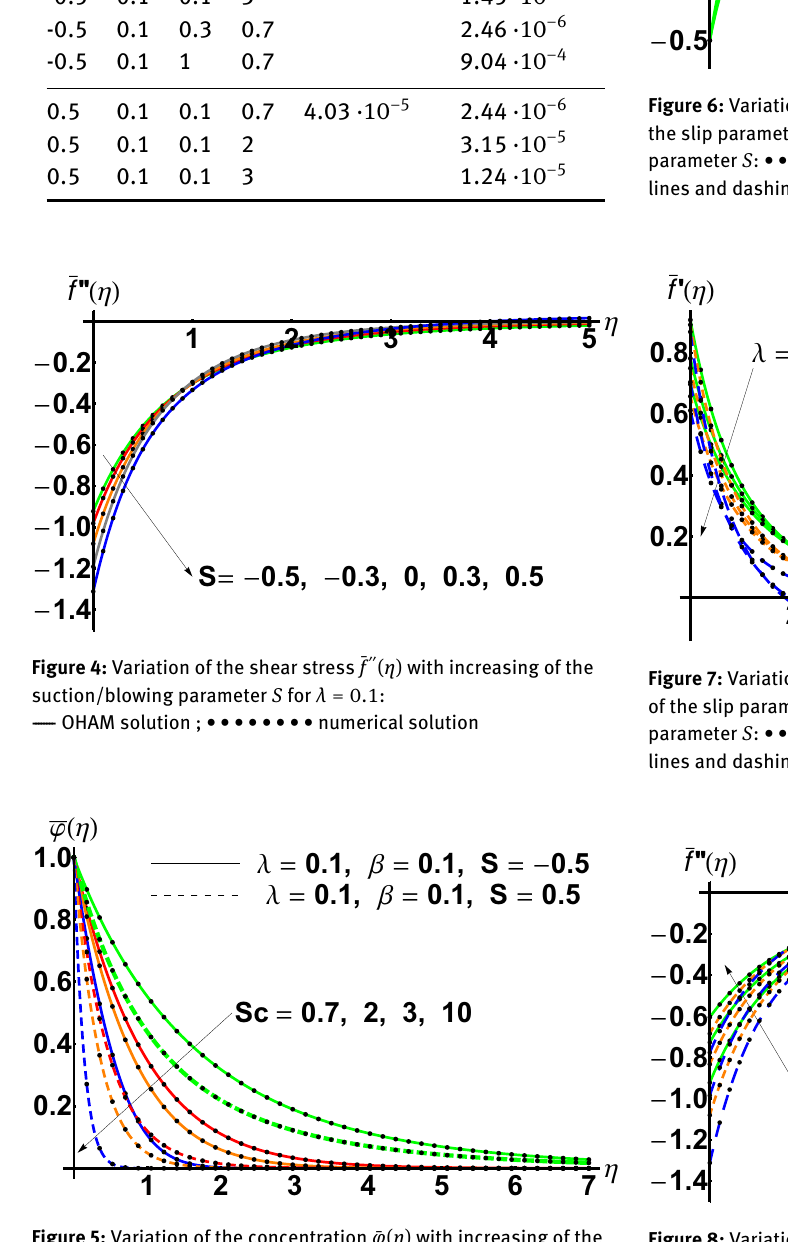
Figure 8: Variation of the shear stress ¯ f ′′ ( η ) with increasing of the slip parameter λ for different values of the suction/blowing param- eter S : •••••••• numerical solution ; OHAM solution (with lines and dashing lines